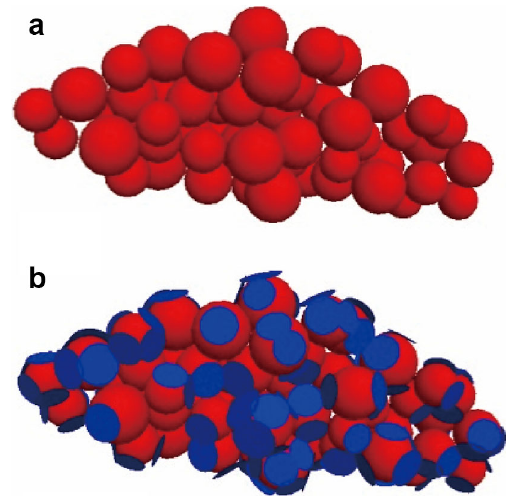
Fig. 11 Illustration of 3D soil/rock interfaces and contacts, a 3D rock geometry, b soil/rock interfaces and contacts surrounding the rock